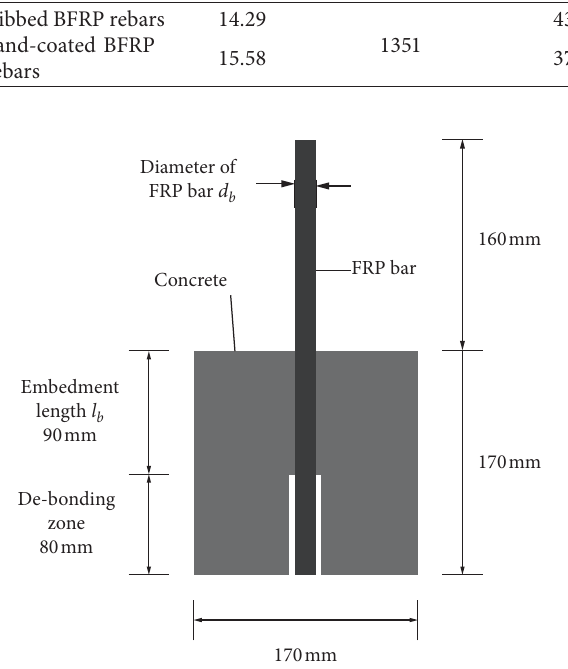
Figure 3: Specimen for pullout